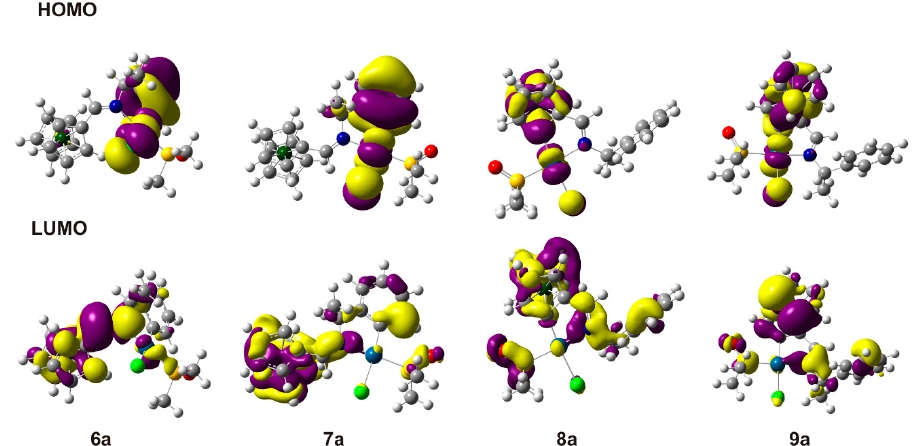
Figure 6. Highest occupied molecular orbital (HOMO) and LUMO orbitals for the cycloplatinated compounds 6a – 9a .